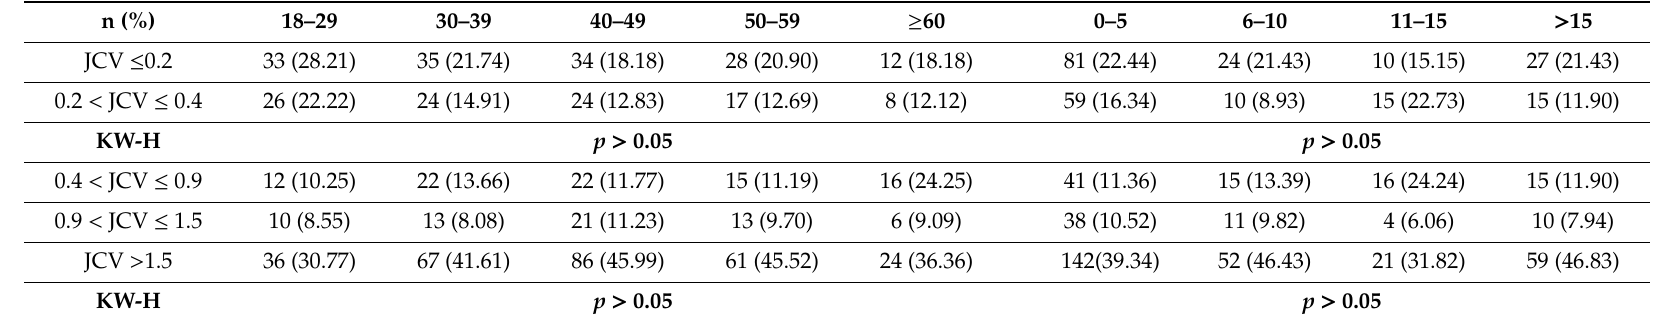
Table 6. Anti-JCV antibodies index categories and patients’ age and disease